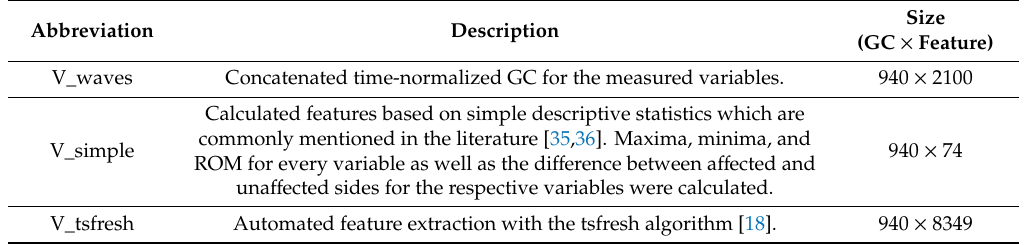
Table 1. Input vectors used for modeling. Twenty gait cycles (GCs) per subject were extracted. To reduce the number of irrelevant features of V_simple and V_tsfresh, the fresh-algorithm (FeatuRe Extraction based on Scalable Hypothesis tests) [18] was applied as a filter. ROM = range of